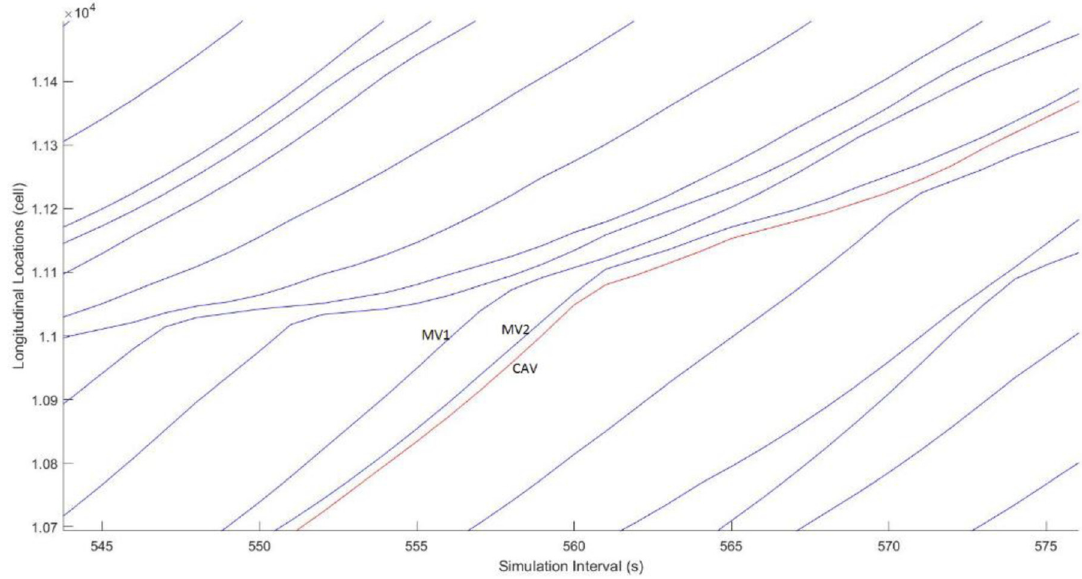
Figure 3 Following front gap comparison based on